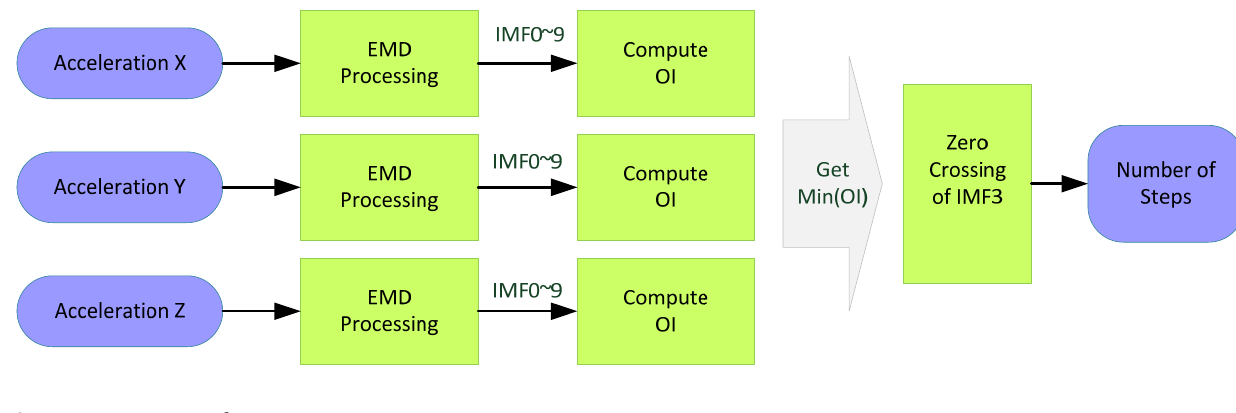
Figure 10. Flow diagram of counting the number of walking